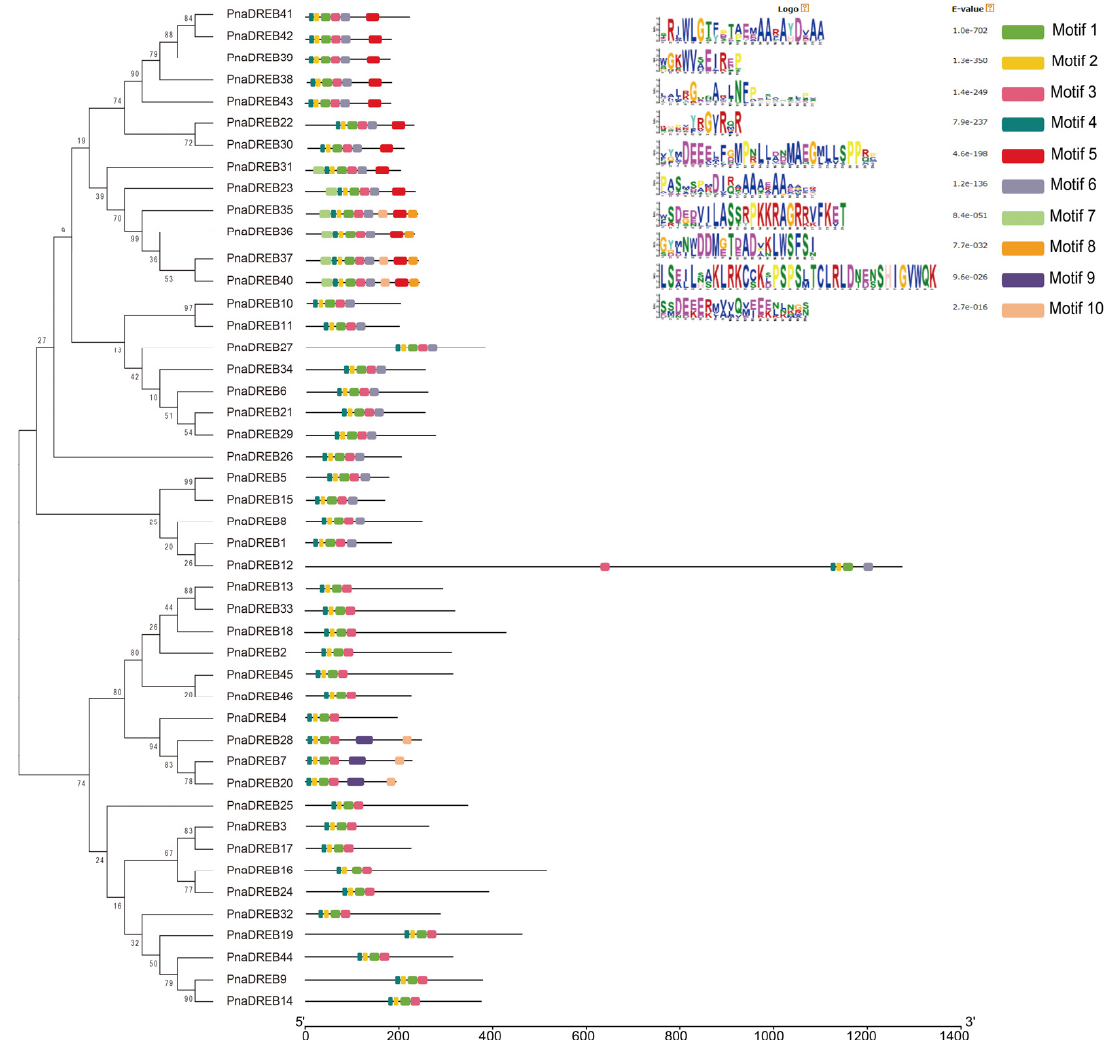
Figure 4. PnaDREB gene motif analyses. Di ff erent conserved motifs are represented with boxes colored based on motif identity. In total, 10 conserved motifs were identi fi ed.